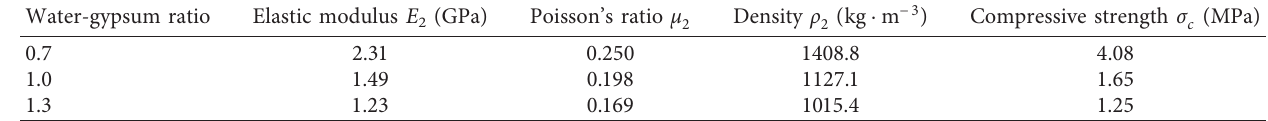
Table 3: The physical parameters of the gypsum rods with different water-gypsum ratios. Water-gypsum ratio